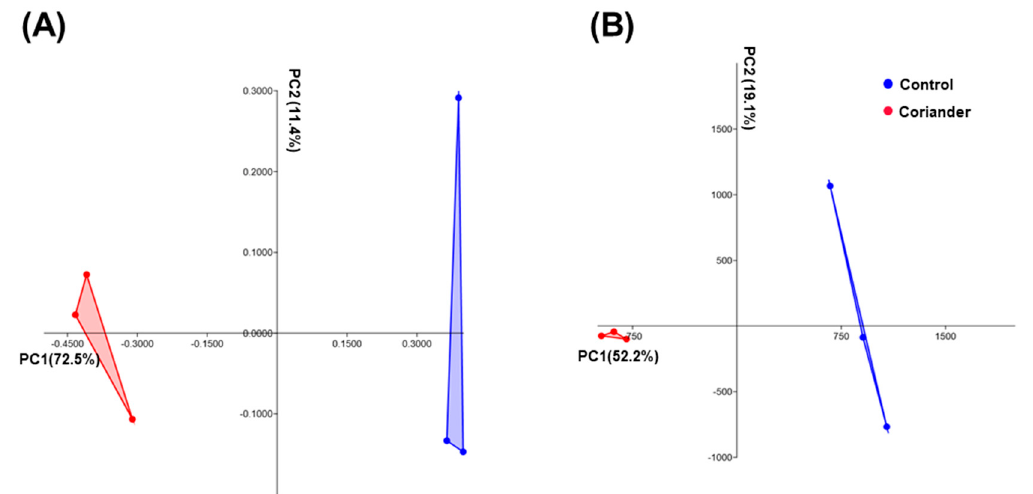
Figure 2. Principle coordinates analysis of ( A ) Bray–Curtis and ( B ) Euclidean distances of soy sauce samples prepared by adding coriander during fermentation, compared to those of control. Each dot represents a replicate from the different groups of soy sauce.